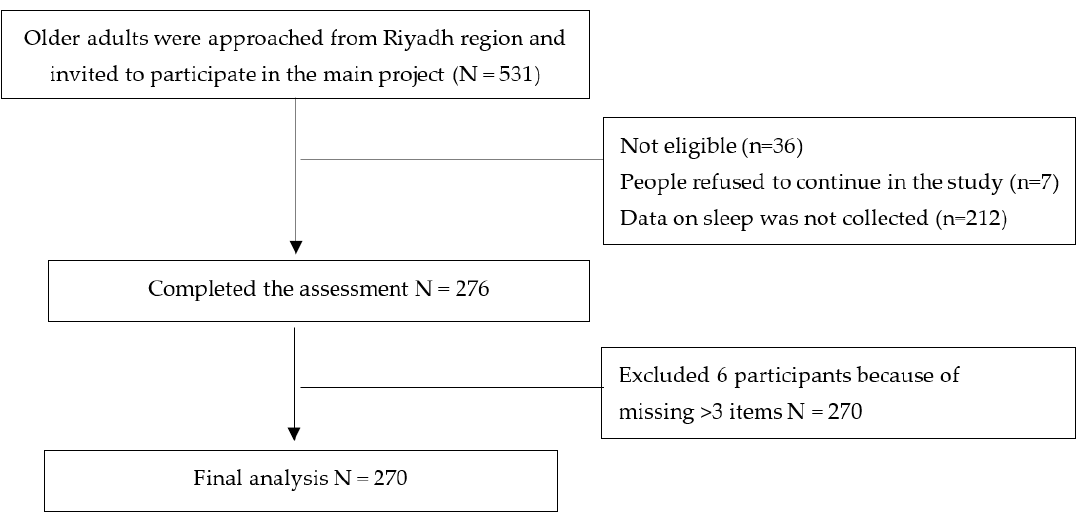
Figure 1. Flow chart of participants’ enrollment.